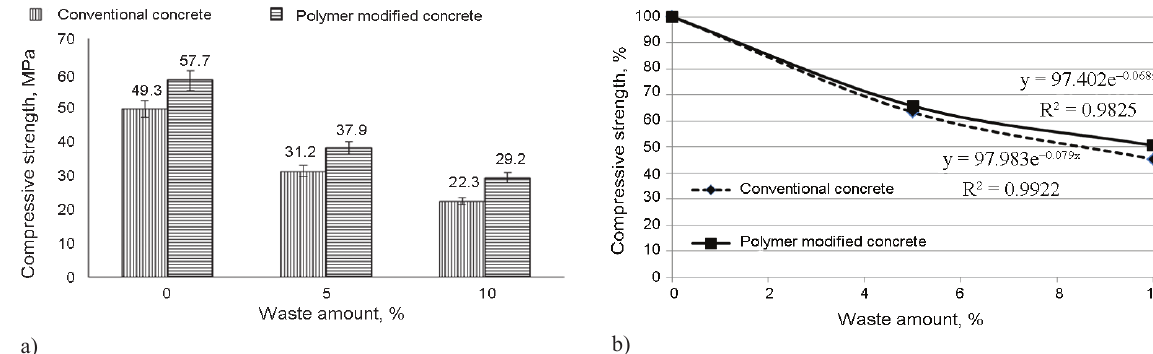
Fig. 4. influence of the amount of ecW on the compressive strength of concrete samples in MPa (a) and in %